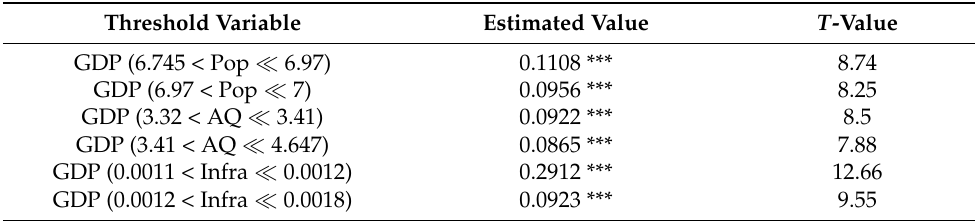
Table 9. Panel threshold regression